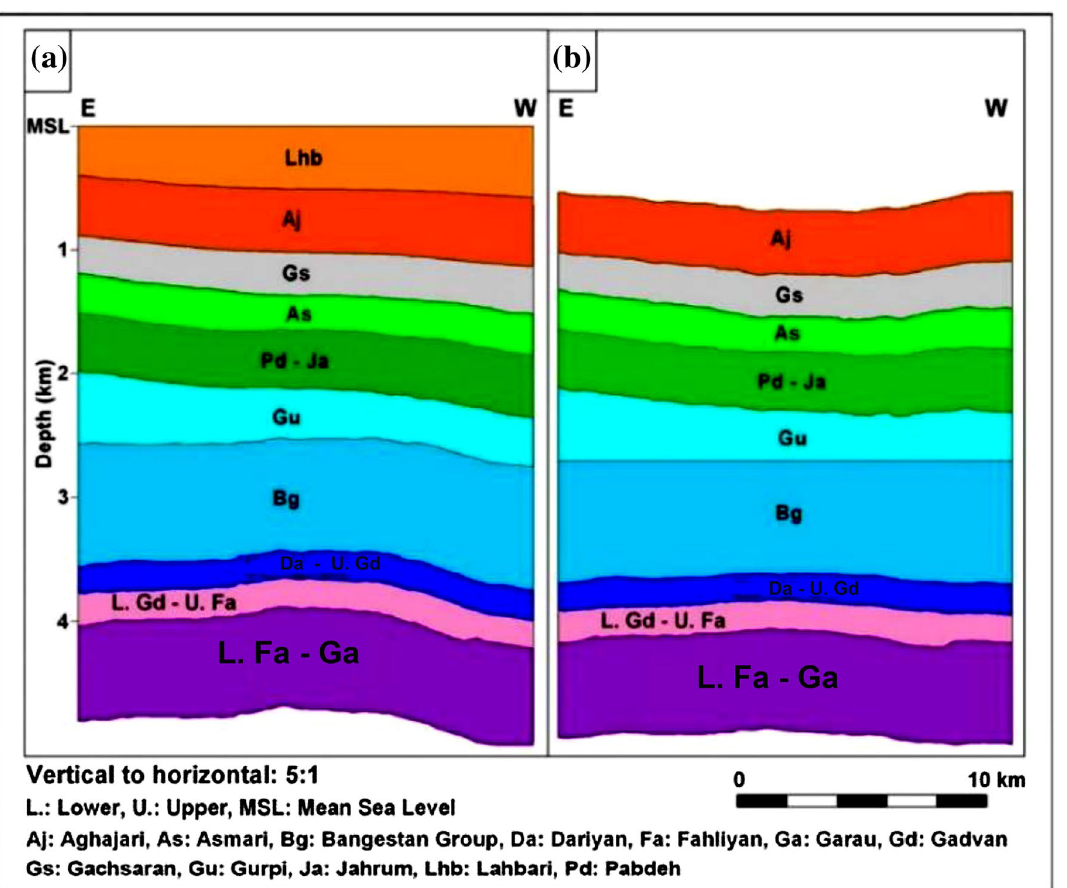
Fig. 2 a A structural cross section of the Azadegan Anticline in E-W direction. b The structural cross section is flattened at the top Bangestan Group (Abdollahie Fard et al.